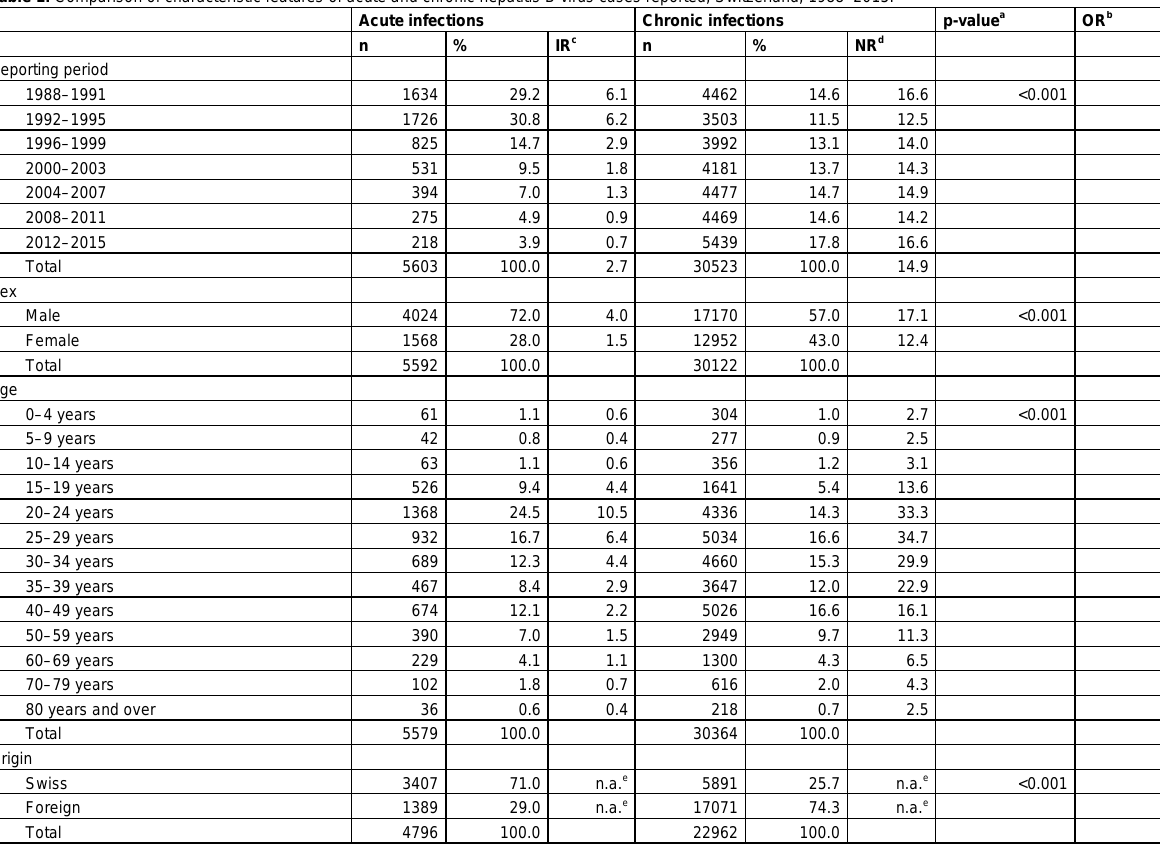
Table 1: Comparison of characteristic features of acute and chronic hepatitis B virus cases reported, Switzerland, 1988–2015. Acute infections Chronic infections p-value a OR